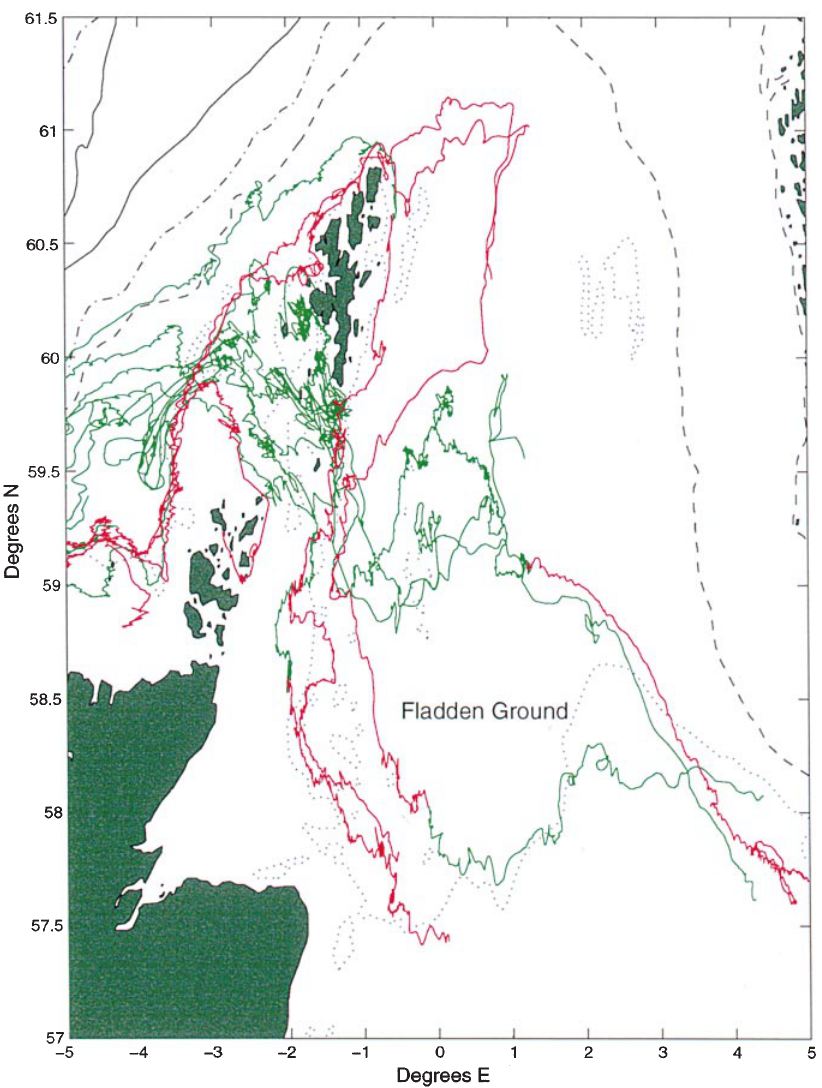
Fig. 9. Drifter tracks near the Fair Isle Channel, coloured by time of year in 1996 and 1997. Green indicates paths between 1 January and 1 August, 1996, and red other- wise. The general movement of drifters is from to west to